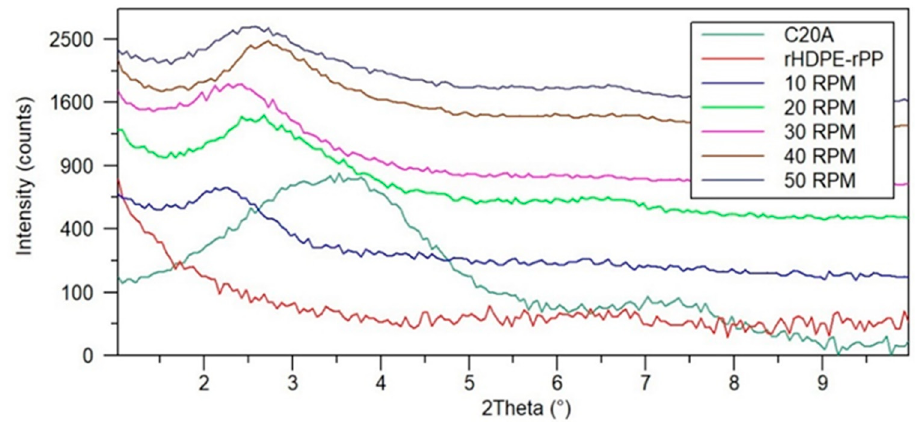
Figure 4. X-ray diffractometry of the 97% rHDPE/rPP and 3% C20A blend at different screw speeds, JCPDS-Card No. #00-007-0330.